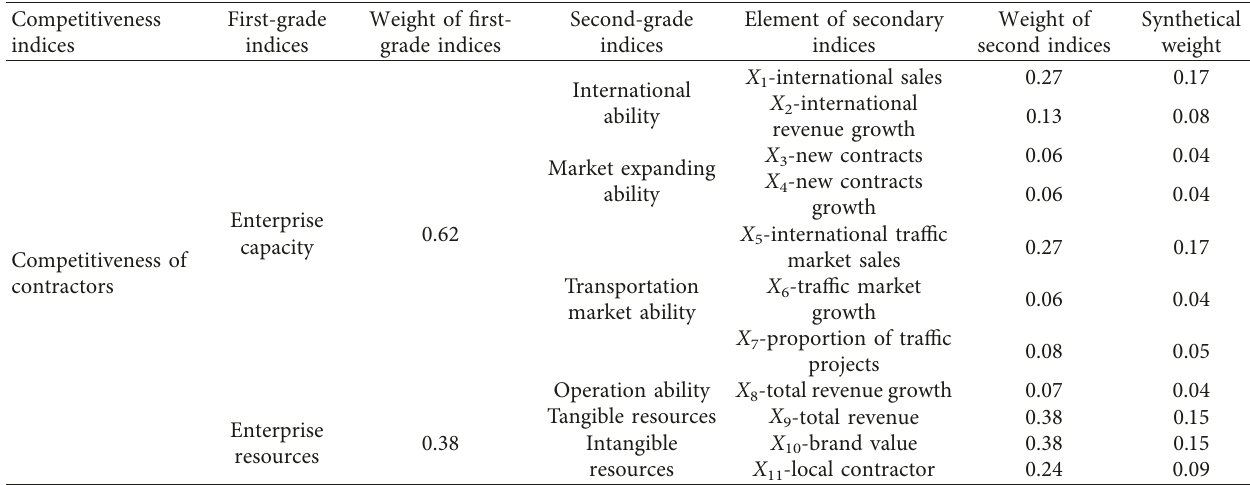
Figure 2: Evaluation system of HSR construction contractors’ competitiveness. Table 2: Weight of evaluation